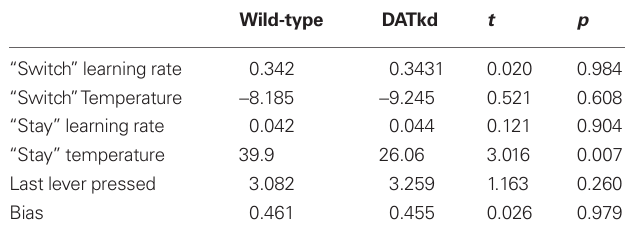
Table 2 | Fitted model parameters by